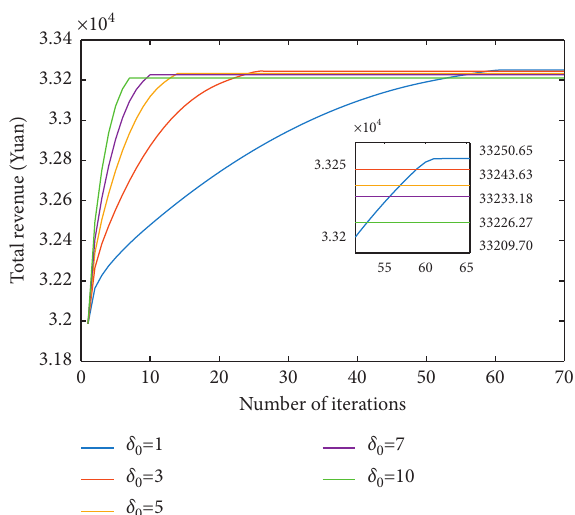
Figure 8: The total revenue changing with different δ